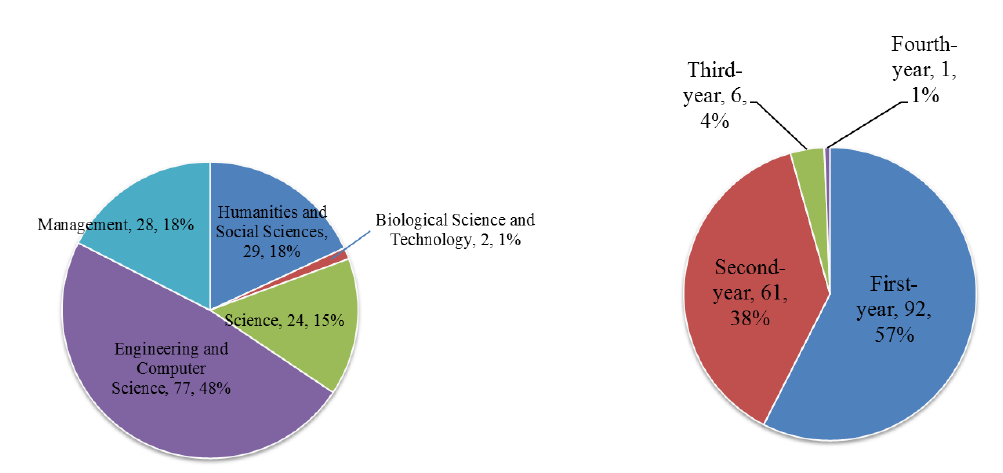
Figure 2. Distribution chart of participants’ school and grade